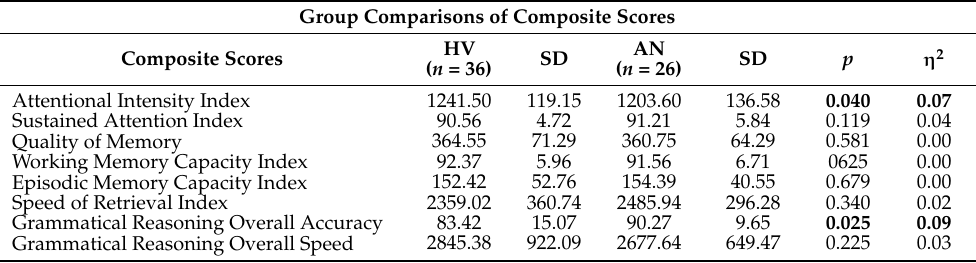
Table 2. Results of ANCOVA, adjusting for age, education, and gender, comparing results of composite scores between patients with AN at baseline and HV, displaying mean, standard deviation, p -values, and effect sizes. Significant differences were highlighted in